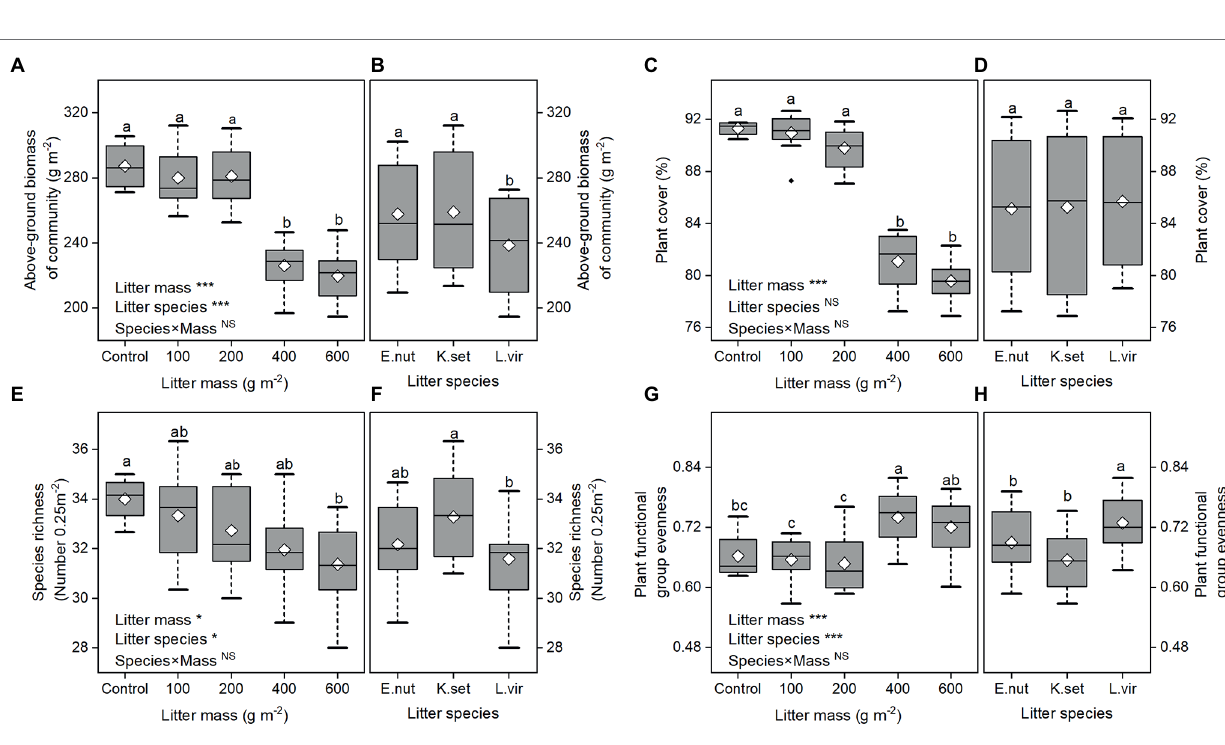
FIGURE 2 | Effects of litter mass and species on plant communities. Above-ground biomass of community (A,B) , plant cover (C,D) , species richness (E,F) , and plant functional group evenness (G,H) . Lowercase letters indicate significant differences at p < 0.05 (* p < 0.05 and *** p < 0.001; NS, not significant). Box plots show midline, mean; box edges, first quartile and third quartile; and whiskers, minimum and maximum. E. nut , E. nutans ; K. set , K. setchwanensis ; L. vir , L. virgaurea